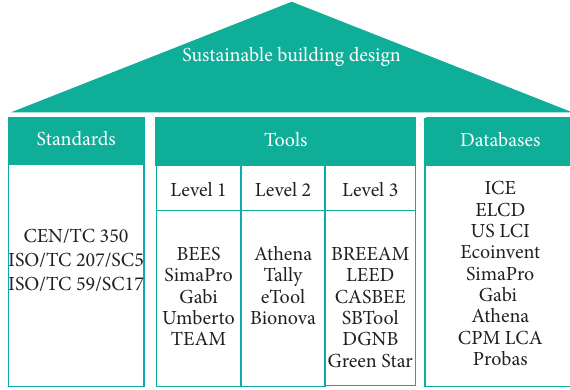
Figure 1: Methods for achieving sustainable